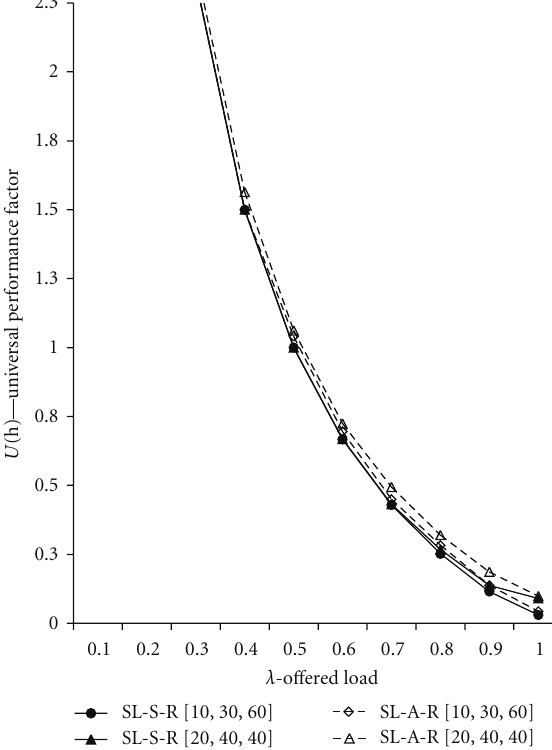
Figure 8: Normalized delay of low-priority packets versus o ff ered load.